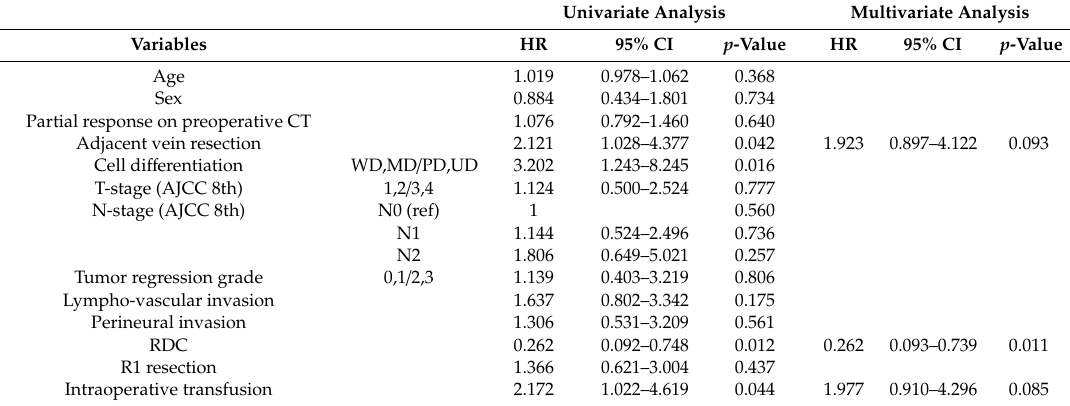
Table 3. Univariate and multivariate analyses of factors associated with overall survival in patients with pancreatic cancer and carbohydrate antigen 19-9 concentrations of 37–1000 U / mL before neoadjuvant chemotherapy.